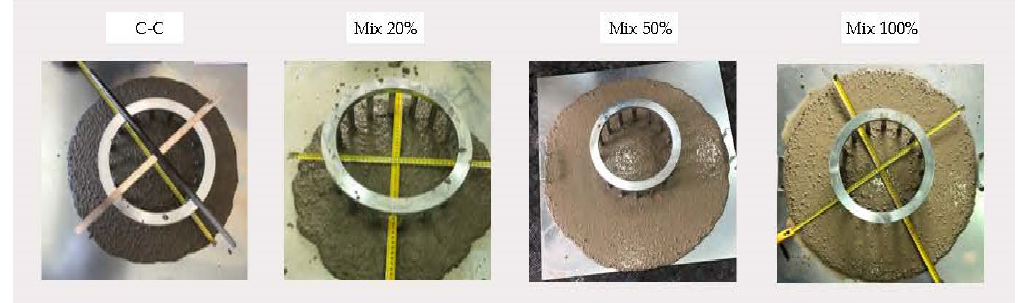
Figure 6. Japanese Ring test.